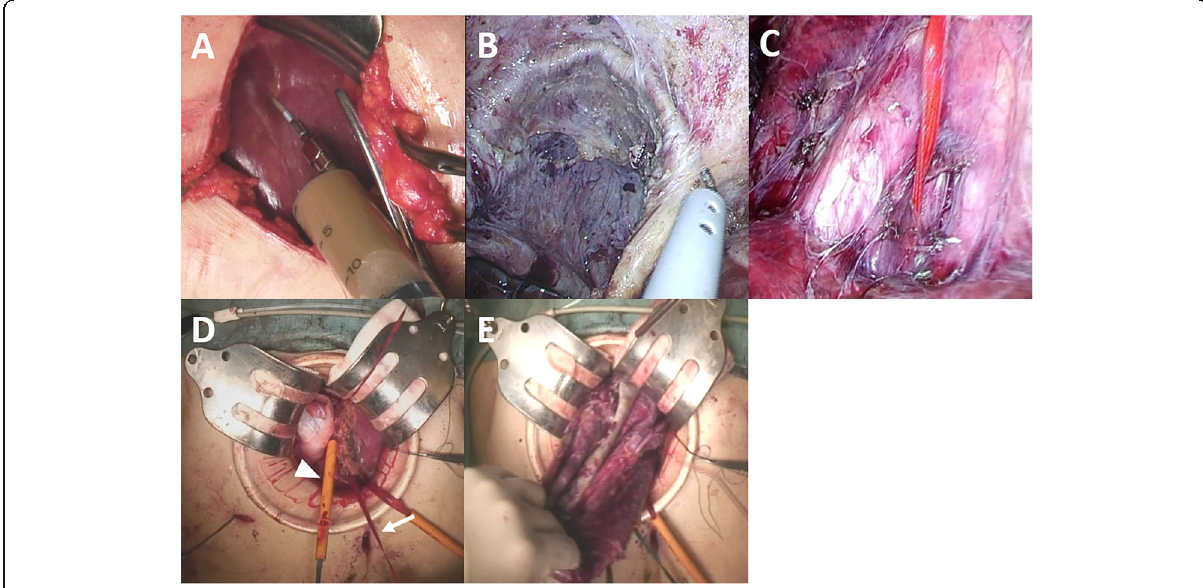
Fig. 3 Surgical procedures. a The cyst content with chocolate color was trans-hepatically aspirated from a 7-cm upper midline incision. b The adhesiotomy between the cyst wall and right diaphragm was laparoscopically performed without rupturing the cyst wall. c Preparation for a hanging maneuver was performed. d Parenchymal division was performed under direct vision through the small laparotomy wound using a hanging maneuver (arrow) and the Pringle ’ s maneuver (arrowhead). e The specimen was carefully excised from the